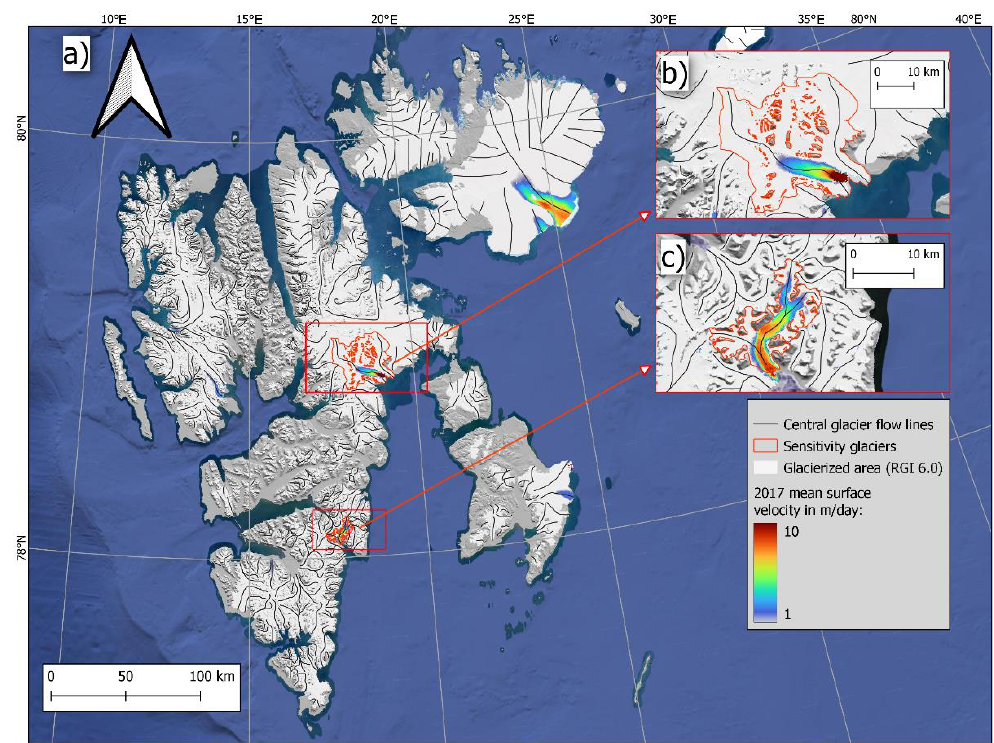
Figure 1. ( a ) Overview of the Svalbard Archipelago. Glacier outlines and glaciated areas according to RGI6.0 Consortium (white); black lines represent one or multiple central flow lines according to [30] (pers. communication) at which velocity data was extracted; Mean surface velocity of 2017 is displayed in a continuous colour bar see legend; note that any velocities <1 m/day are not displayed. Inlet ( b ) and ( c ) show location and outlines, as well as central flow lines of ( b ) Negribreen and ( c ) Strongbreen which were used for the sensitivity study in this paper.